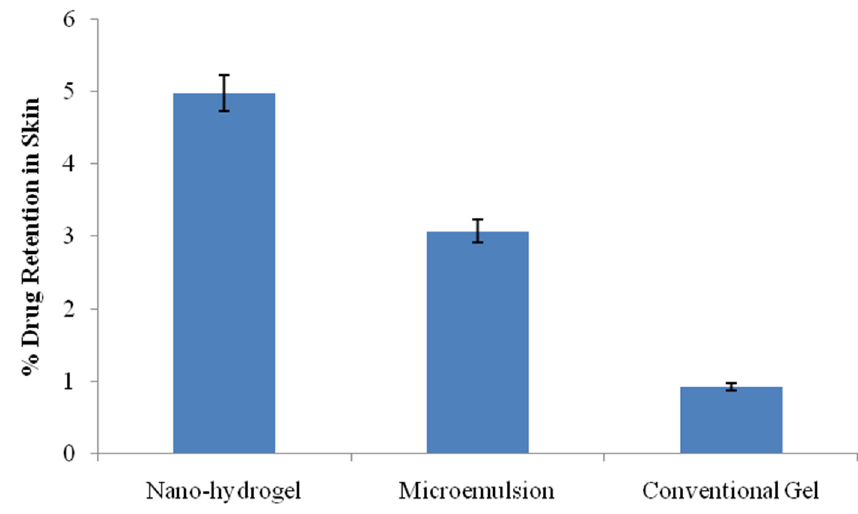
Figure 9. Drug retention in the skin from the studied formulations (n = 3).